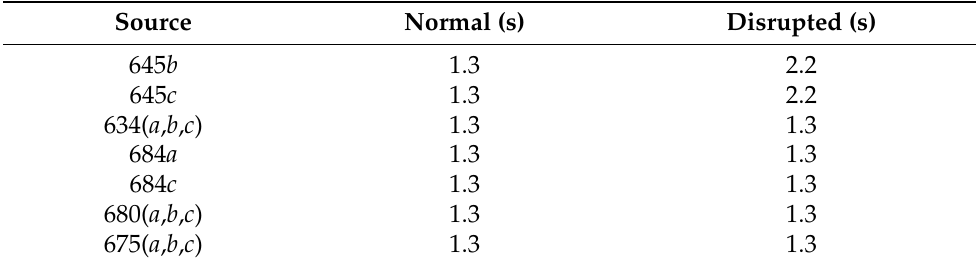
Table 3. Route times for DERs to utility